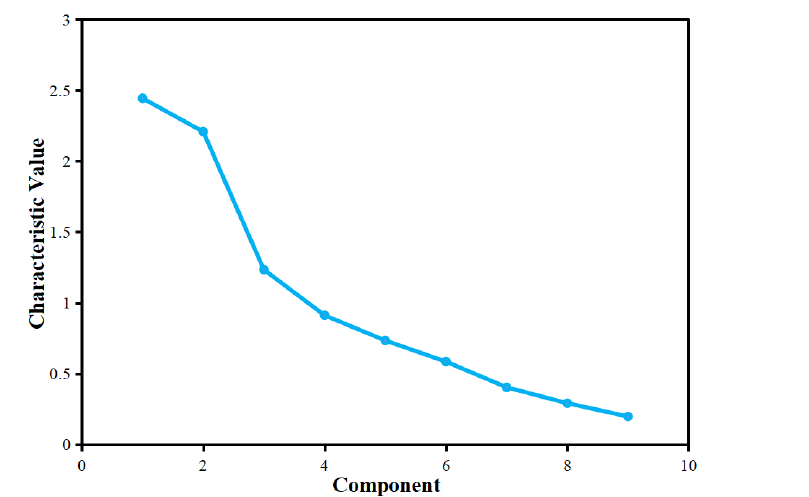
Figure 6. Gravel diagram of PCA. Table 3. List of principal